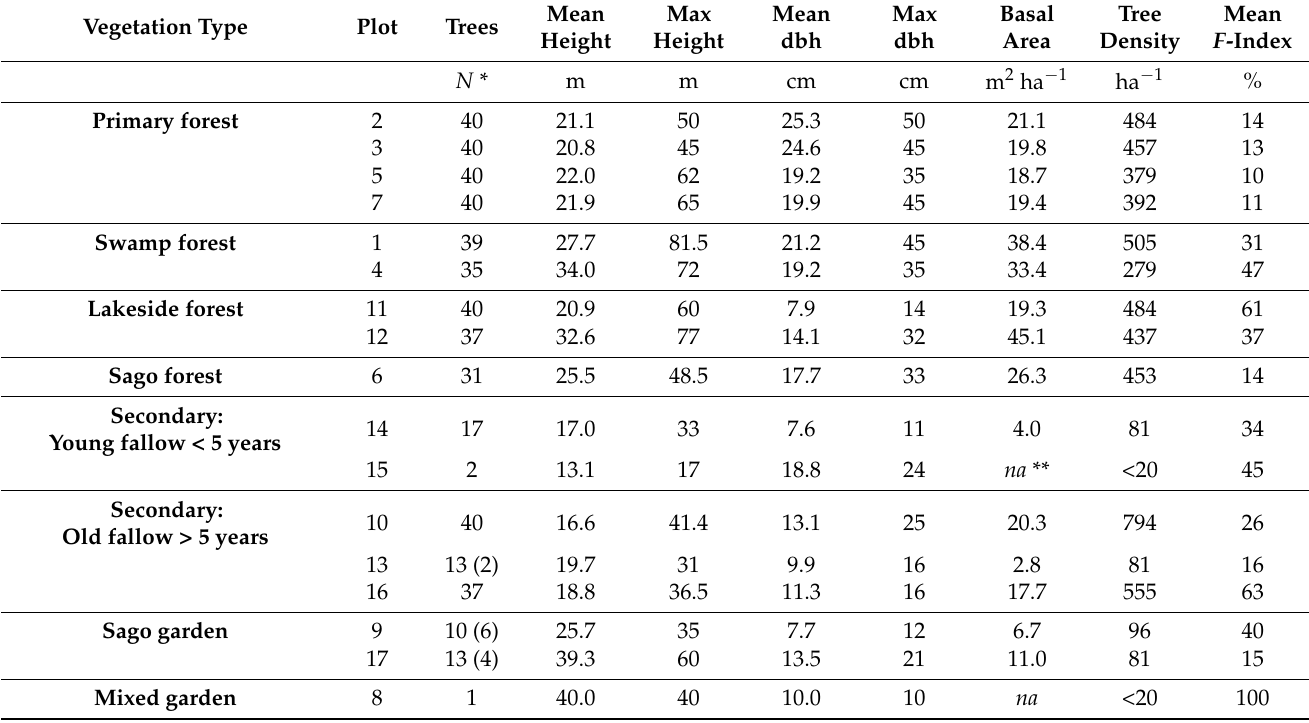
Table 2. Forest structure by plot for stems ≥ 10 cm diameter at 1.3 m height (dbh). Vegetation